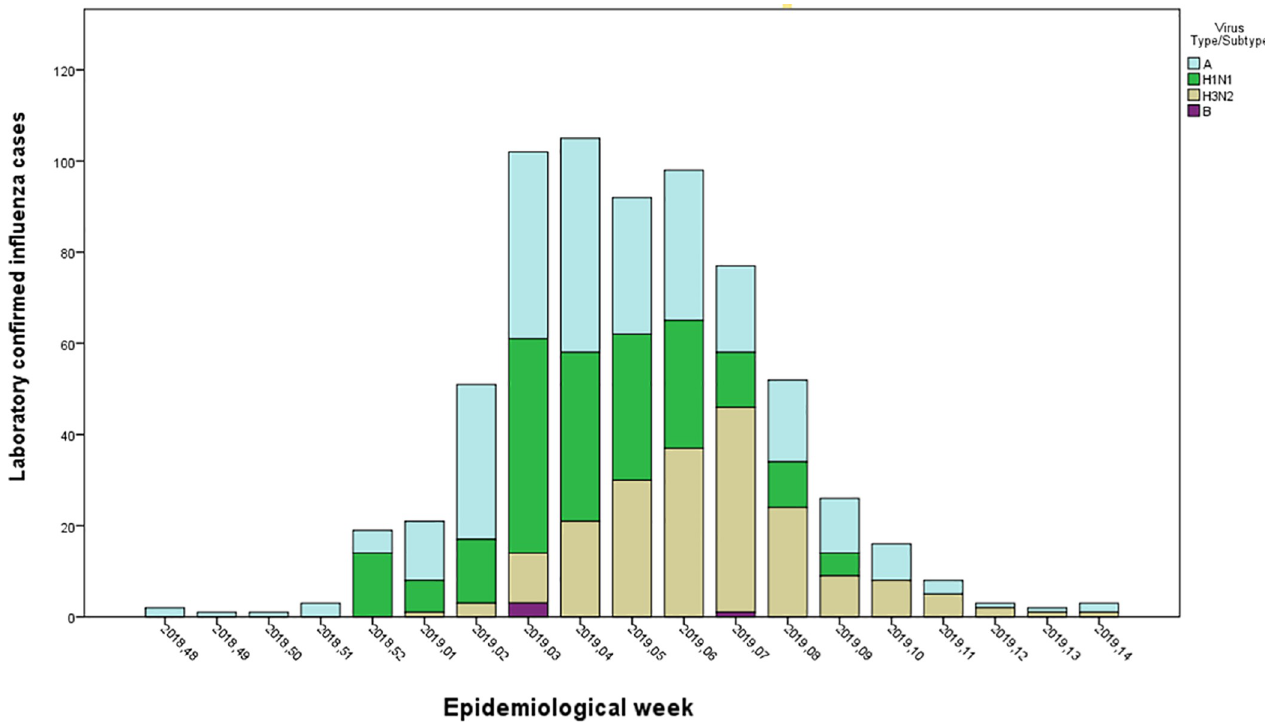
Fig 1. Influenza virus types/subtypes detected by epidemiological week at the GTiPUH laboratory during the 2018–2019 influenza season.